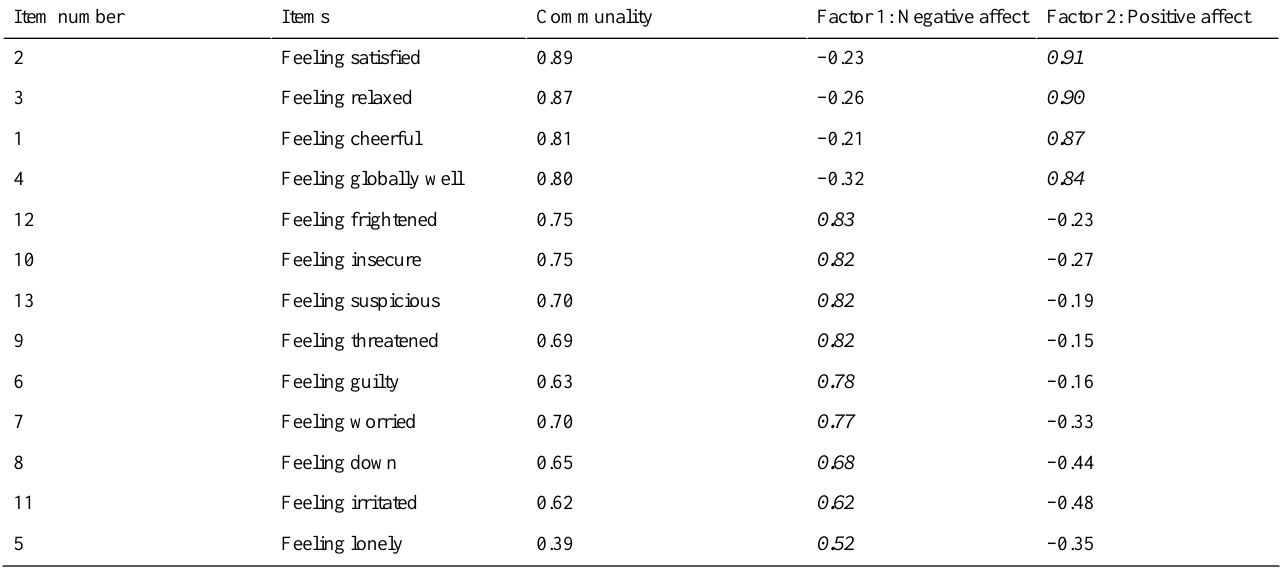
Table 2. Factor loadings from EFA a of the K-PsyMate scale (n=1929). b